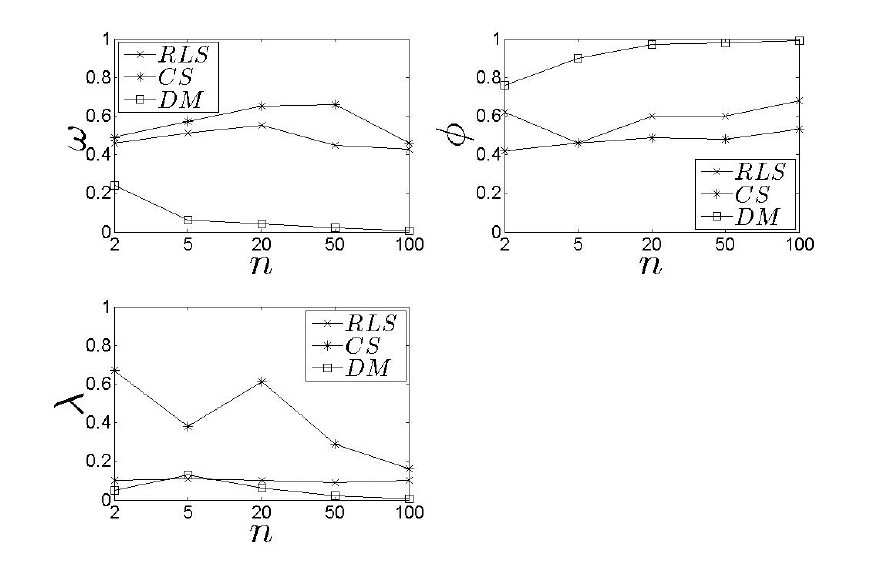
Figure 16. Comparison results with the DM